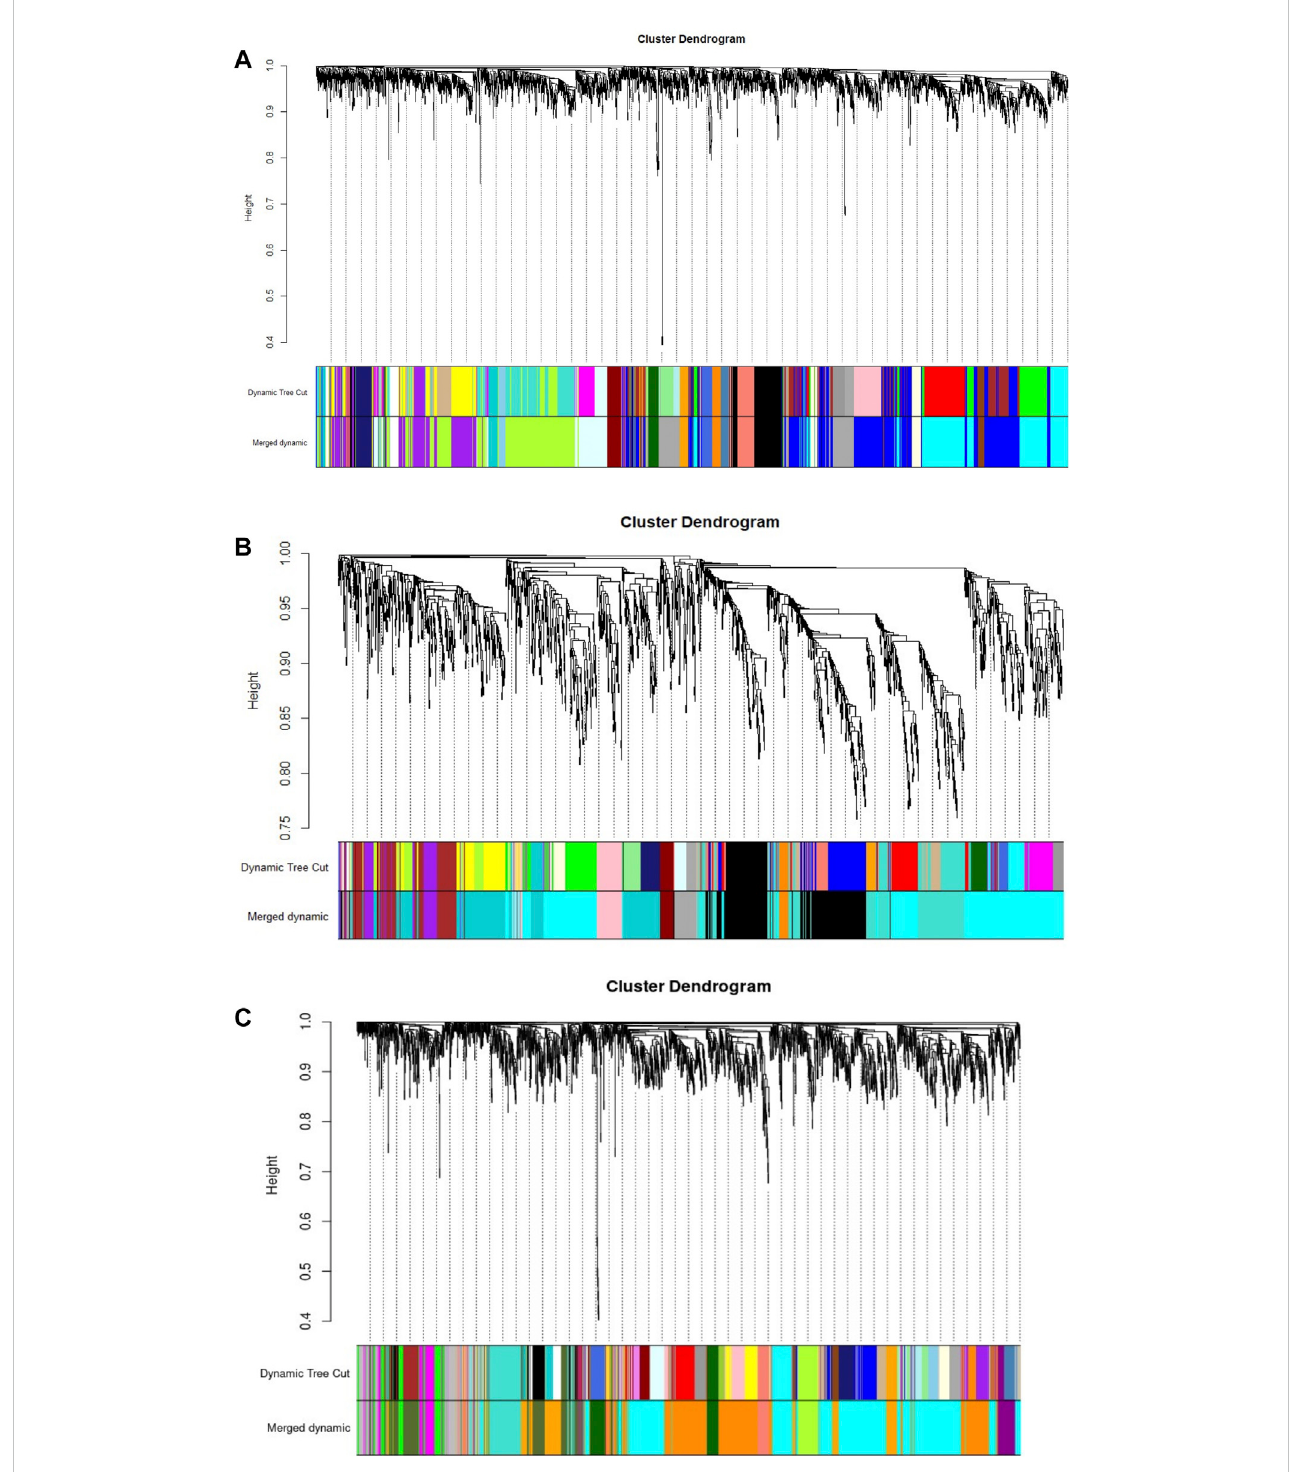
FIGURE 2 Gene clustering, with dissimilarity based on topological overlap (TOM), with the corresponding module colors indicated by the color row (Merged dynamic). (A) B. longum subsp. Infantis ATCC 15697. (B) B. bi fi dum SC555, and (C) B. longum subsp. Longum SC596. Each colored row represents a color- coded module which contains a group of highly connected